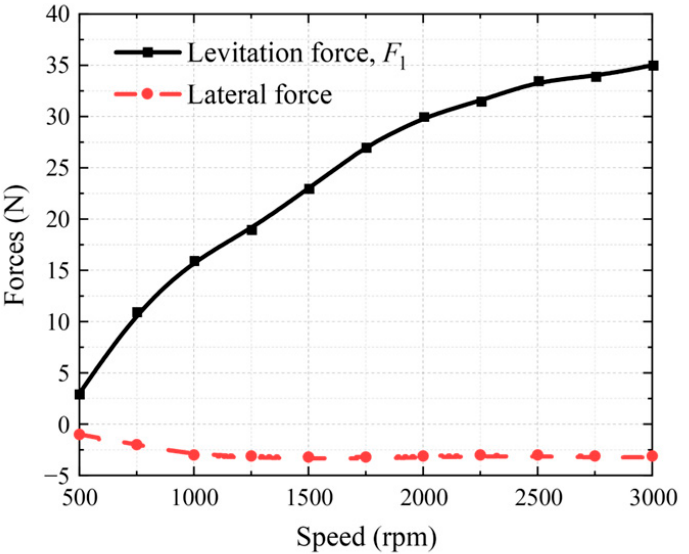
Figure 21. The experimental results of levitation force and guidance force at speeds of 500–3000 rpm. When the PM wheel rotates at a constant speed and the track translates at a constant speed (with and without guidance track), the comparison of the guidance force is shown in Figure 22. When the transverse displacement is 0 mm, the PM wheel is aligned with the aluminum track, and the guidance force with installed guidance track is zero. On the contrary, the guidance force without the installed guidance track is not zero, and the direction of it is negative due to the edge effect, which will push the wheel out of the